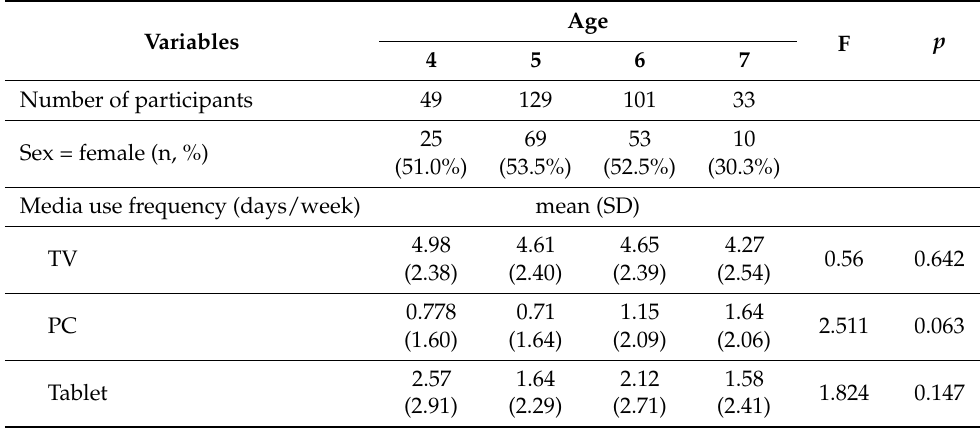
Table 1. Demographics of participants at baseline (n =